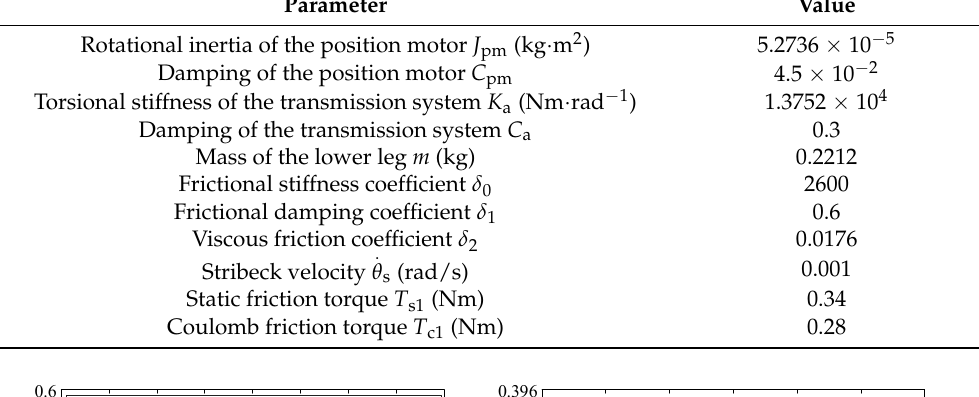
Table 1. Specific simulation parameters of the variable stiffness actuator system.